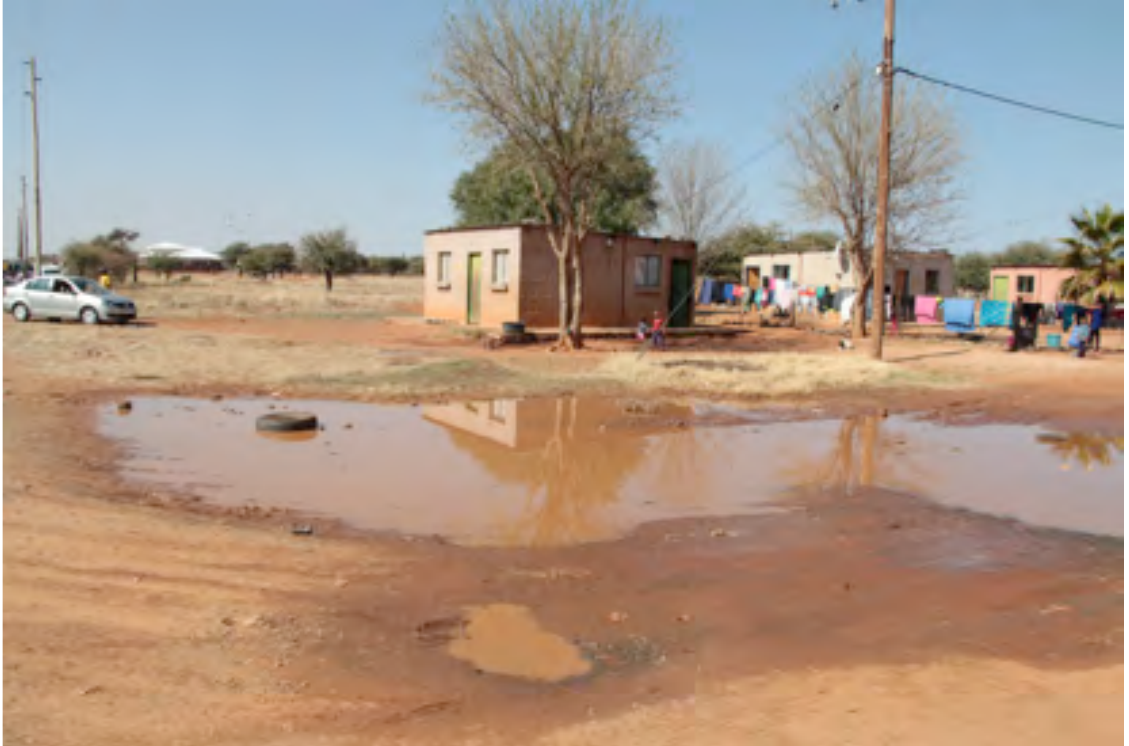
Figure 9 A pipe leak at a T-junction into Kamatoka Street, the main road of Platfontein. In the rainy season the nearby houses are frequently flooded causing